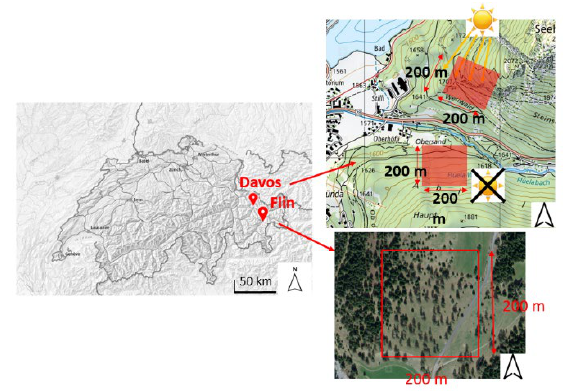
Figure 1 . Field sites of the steep (upper) and flat forests